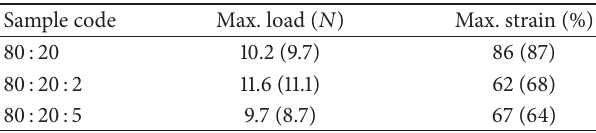
Figure 3: SEM micrograph of distribution of micropores in the compatibilized blend, stretched at optimum conditions. Table 1: Suture holding strength measurement results for TPU:PDMS blends in the ratio 80 :20 with compatibilizer content from 0–5